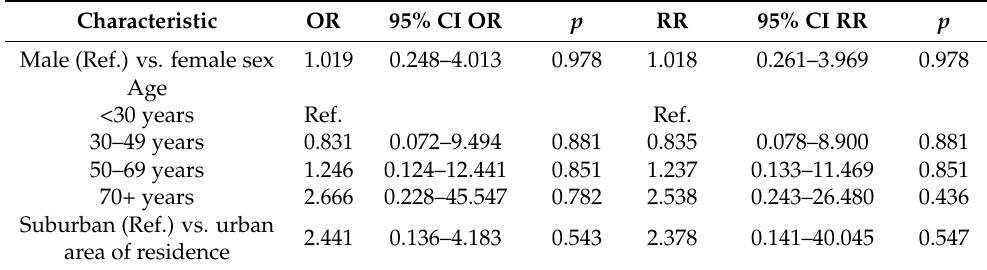
Table 3. Risk analysis for Tahyna virus seropositivity.